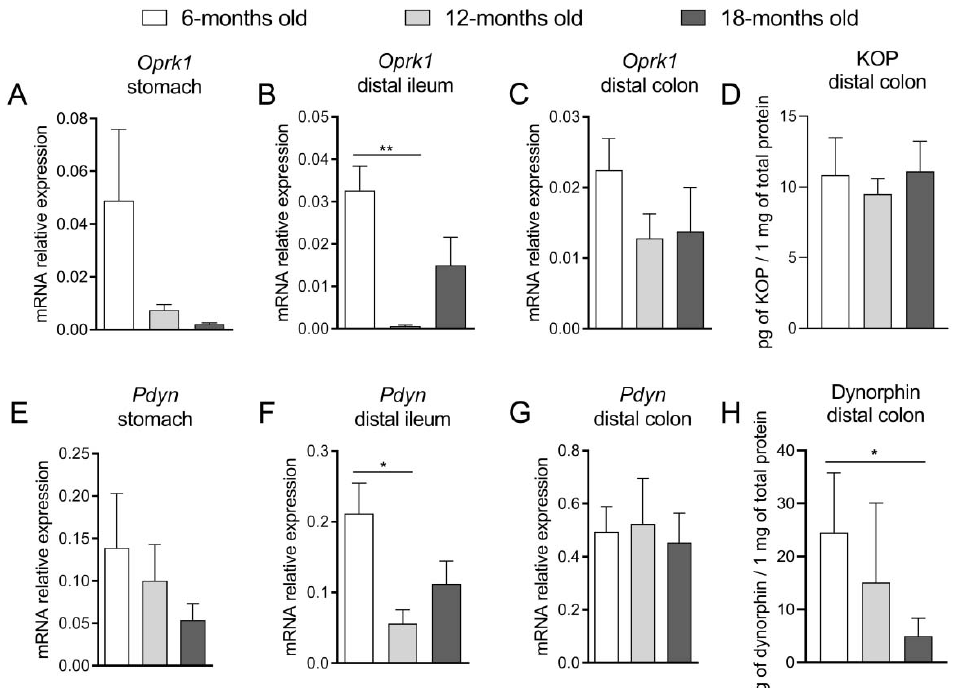
Figure 5. The mRNA expression of the gene Oprk1 , encoding KOP receptor in the stomach ( A ), distal ileum ( B ) and distal colon ( C ). The relative protein expression of KOP receptor in the colon ( D ). The mRNA expression of Pdyn in the stomach ( E ), distal ileum ( F ) and distal colon ( G ) and the concentra- tion of dynorphin in the colon ( H ) in 6-, 12- and 18-months old mice. One-way analysis of variance (ANOVA) followed by Bonferroni correction test was used to evaluate the differences between groups. Bars represent mean ± SEM. * p < 0.05, ** p < 0.01.